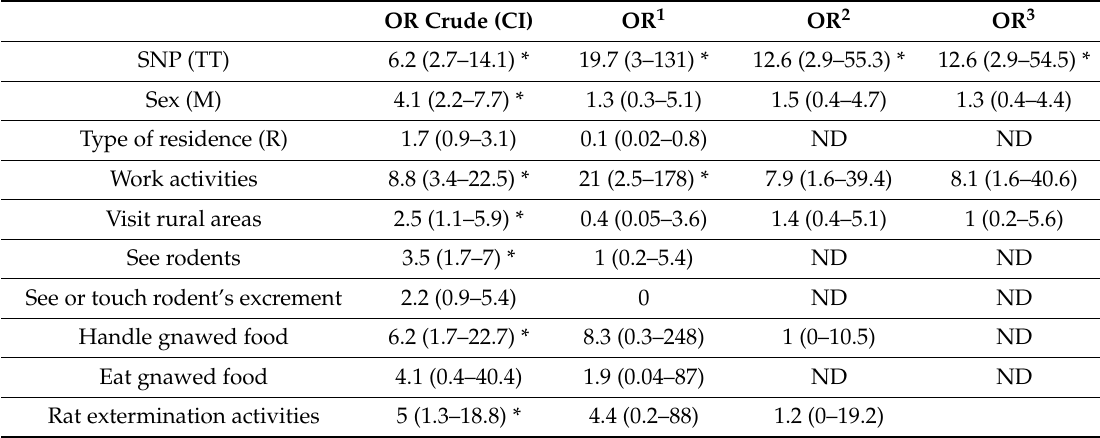
Table 2. Odds-ratios (ORs) for three logistic regression models linking genotypes and risk factors for ANDV acquisition. Data and numbers are shown in Table